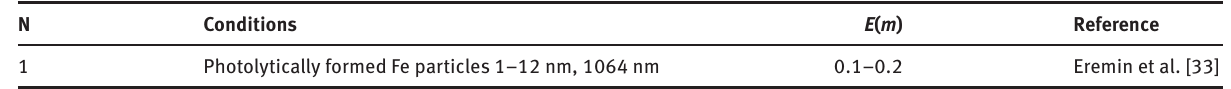
Table 2: The refractive index function values of non-soot particles measured by pulsed laser heating.